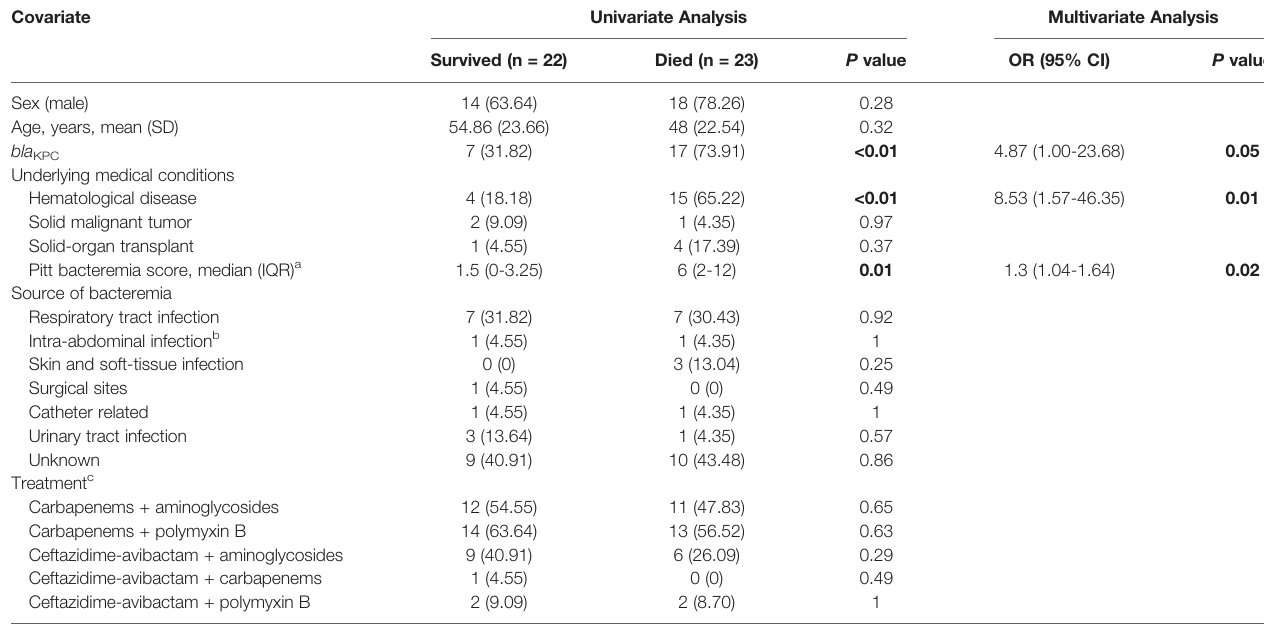
TABLE 2 | Analysis of risk factors for 28-Day mortality in 45 patients with Carbapenem-Resistant P. aeruginosa bloodstream infection. Covariate Univariate Analysis Multivariate